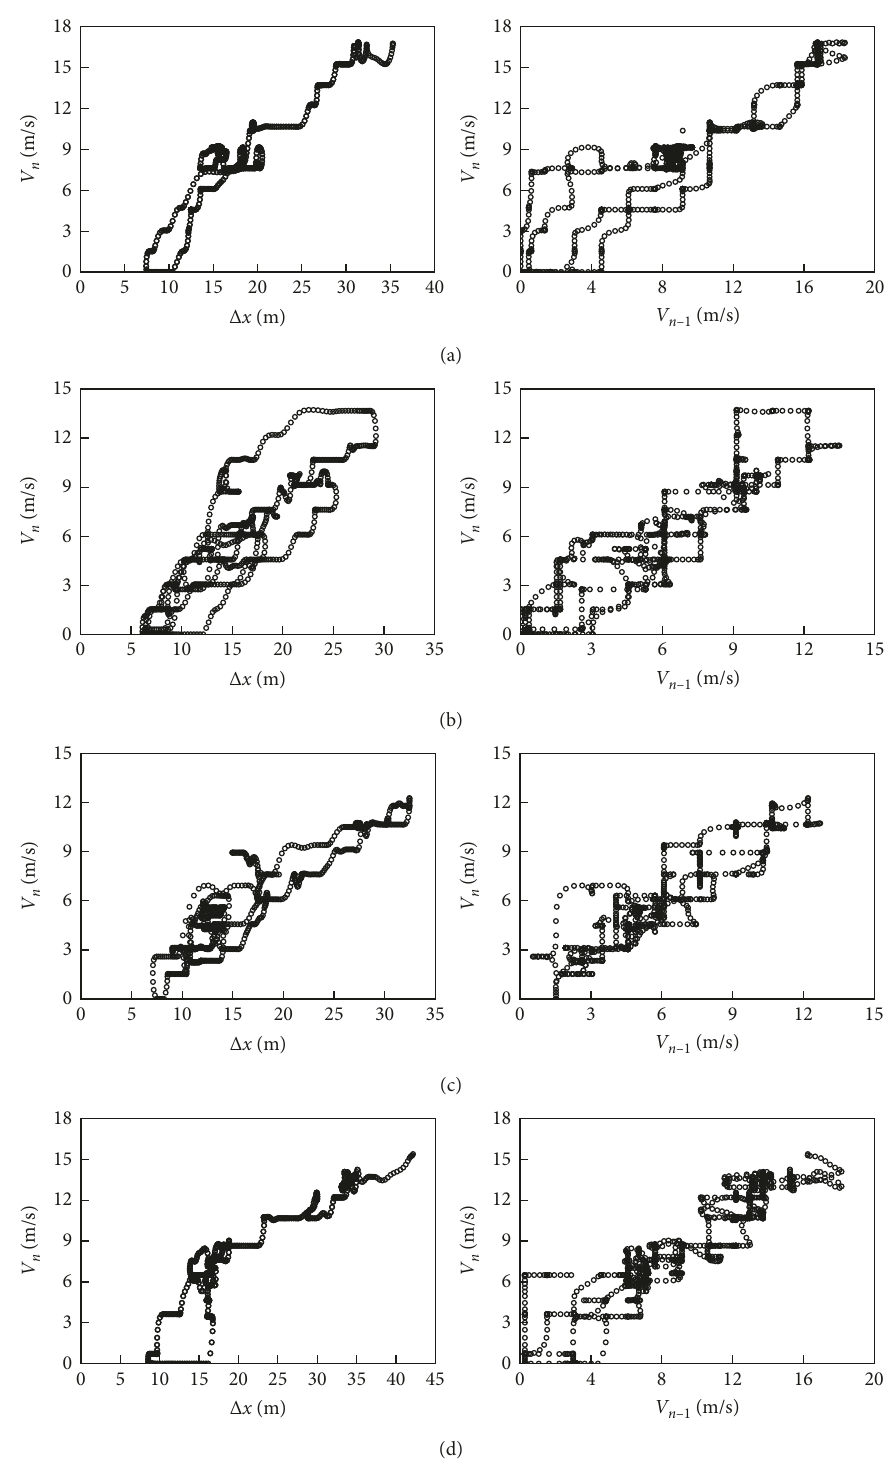
Figure 4: Illustration of correlations of speed of the lag vehicle with vehicle spacing and speed of the lead vehicle. (a) Vehicle No. 783 following vehicle No. 778 in lane 1, (b) vehicle No. 1,246 following vehicle No. 1,241 in lane 2, (c) vehicle No. 1,240 following vehicle No. 1,233 in lane 3, and (d) vehicle No. 938 following vehicle No. 934 in lane